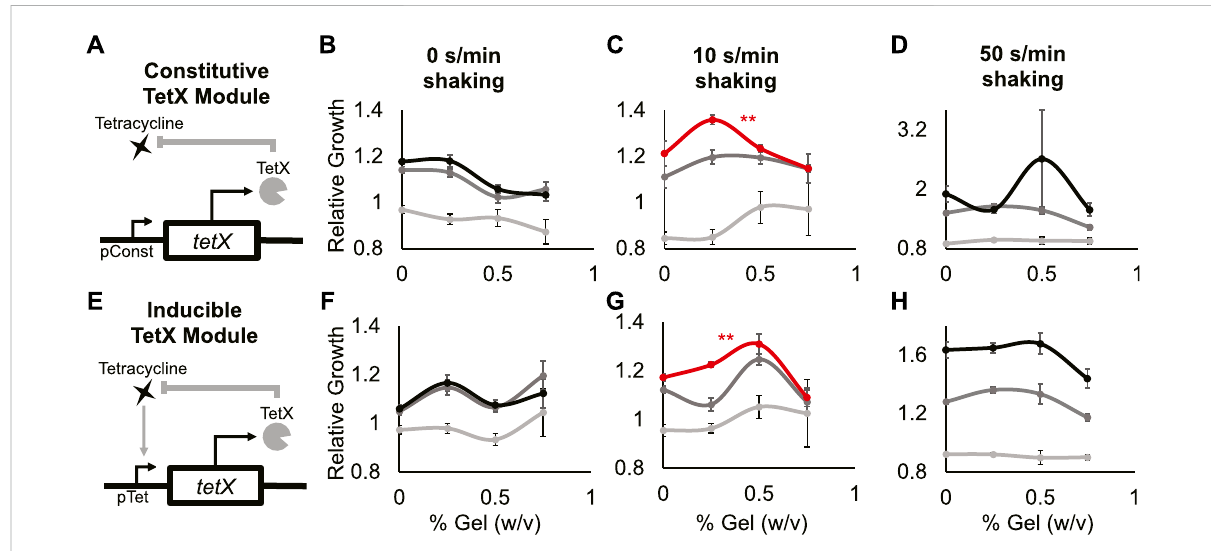
FIGURE 3 A minimal antibiotic-resistance module enables frequency-dependent response of bacterial growth in hydrogel. (A) Abstract depiction of tetracycline degradation by constitutive TetX expression module. (B – D) Relative growth of E. coli cells constitutively expressing TetX with 0 s/min shaking (B) , with 10 s/min shaking (C) , with 50 s/min shaking (D) . Light grey is 0 µg/ml tetracycline, dark grey is 0.3125 µg/ml tetracycline, black is 0.625 µg/ml tetracycline. The red line represents a statistically signi fi cant biphasic curve as judged by a Bonferroni multiple comparisons test (cellstreatedwith0.625 µg/mltetracycline).Pointsrepresentmeanvalues,anderrorbarsrepresentstandarderrorofthemean. (B) and (C) Meanand SEMarecalculatedusingsixbiologicalreplicates. (D) MeanandSEMarecalculatedusingfourbiologicalreplicates. (E) Abstractdepictionoffeedback between bacterial growth and inducible TetX expression module when feeding tetracycline. (F – H) Relative growth of E. coli cells inducibly expressing TetX with 0 s/min shaking (F) , with 10 s/min shaking (G) , with 50 s/min shaking (H) . Light grey is 0 µg/ml tetracycline, dark grey is 0.3125 µg/mltetracycline,blackis0.625 µg/mltetracycline.Theredlinerepresentsastatisticallysigni fi cantbiphasiccurveasjudgedbyaBonferroni multiple comparisons test (cells treated with 0.625 µg/ml tetracycline). Points represent mean values, and error bars represent standard error of the mean. Mean and SEM are calculated using six biological